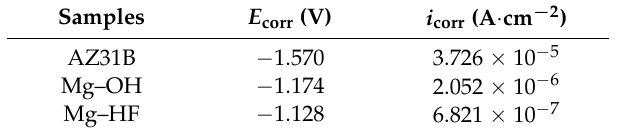
Table 2. The corrosion potentials and corrosion current densities of different samples.